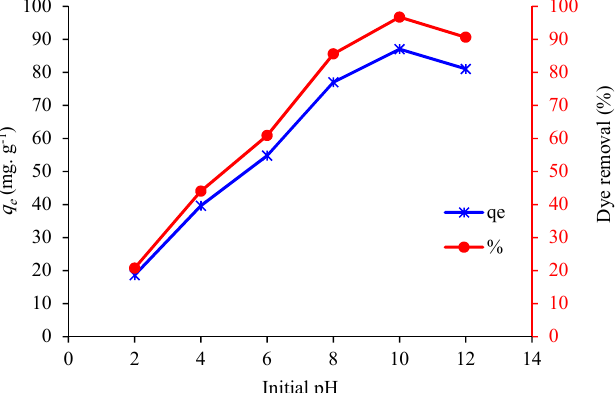
O /C Nanocomposite (C 3 4